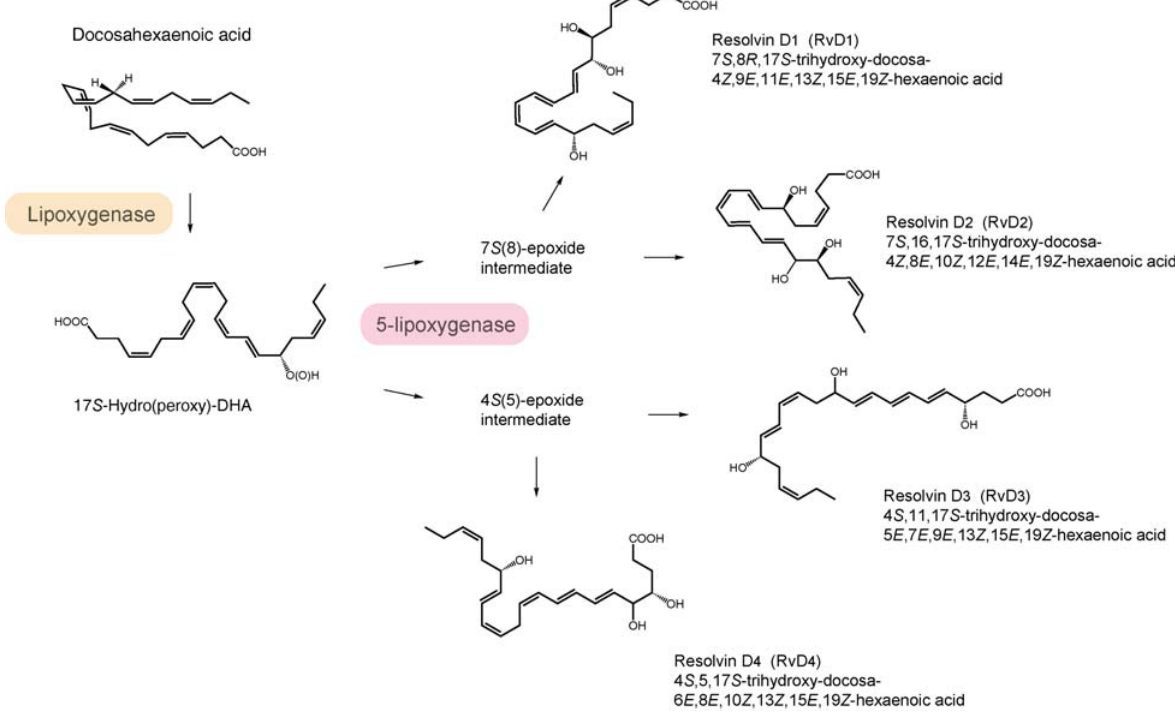
FIGURE 3 . Biosynthesis of D-series resolvins. DHA is the endogenous substrate for the formation of novel D-series resolvins. These lipid mediators are formed by oxygenation via the action of a lipoxygenase at the carbon-17 position forming 17 S -hydroperoxy-DHA, followed by a second oxygenation step catalyzed by neutrophil 5-LO. Note that acetylated COX-2 transforms DHA to 17 R -hydroperoxy-DHA allowing the formation of the corresponding 17 R D-series resolvins (aspirin-triggered